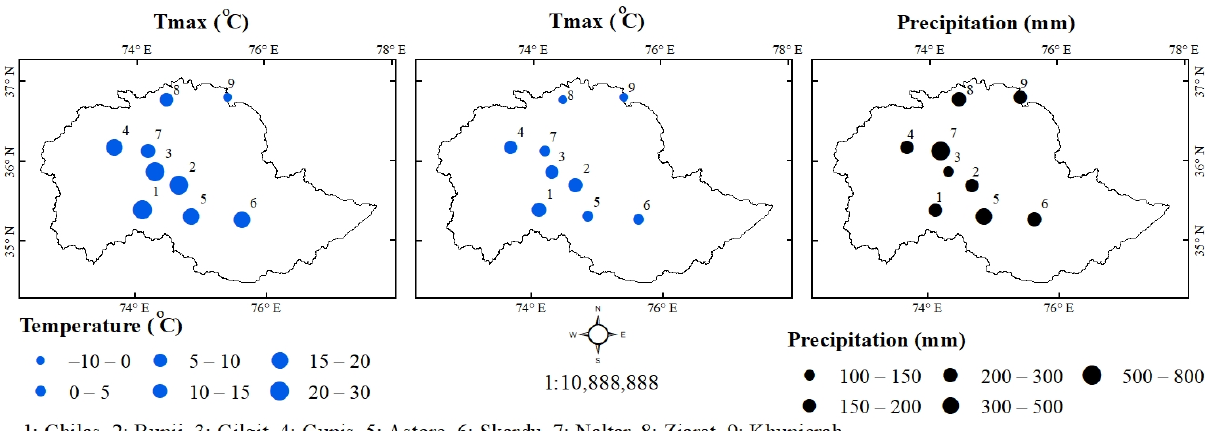
Figure 3. Spatial distribution of mean T max , T min and precipitation.